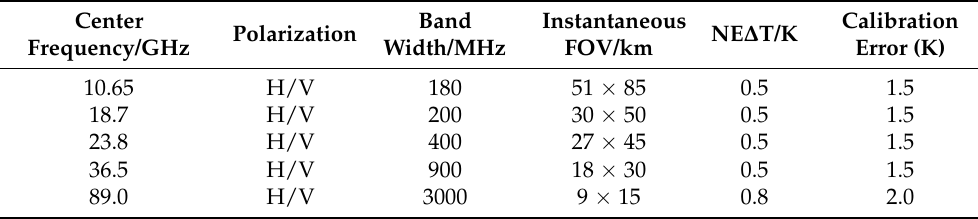
Table 1. MWRI channel